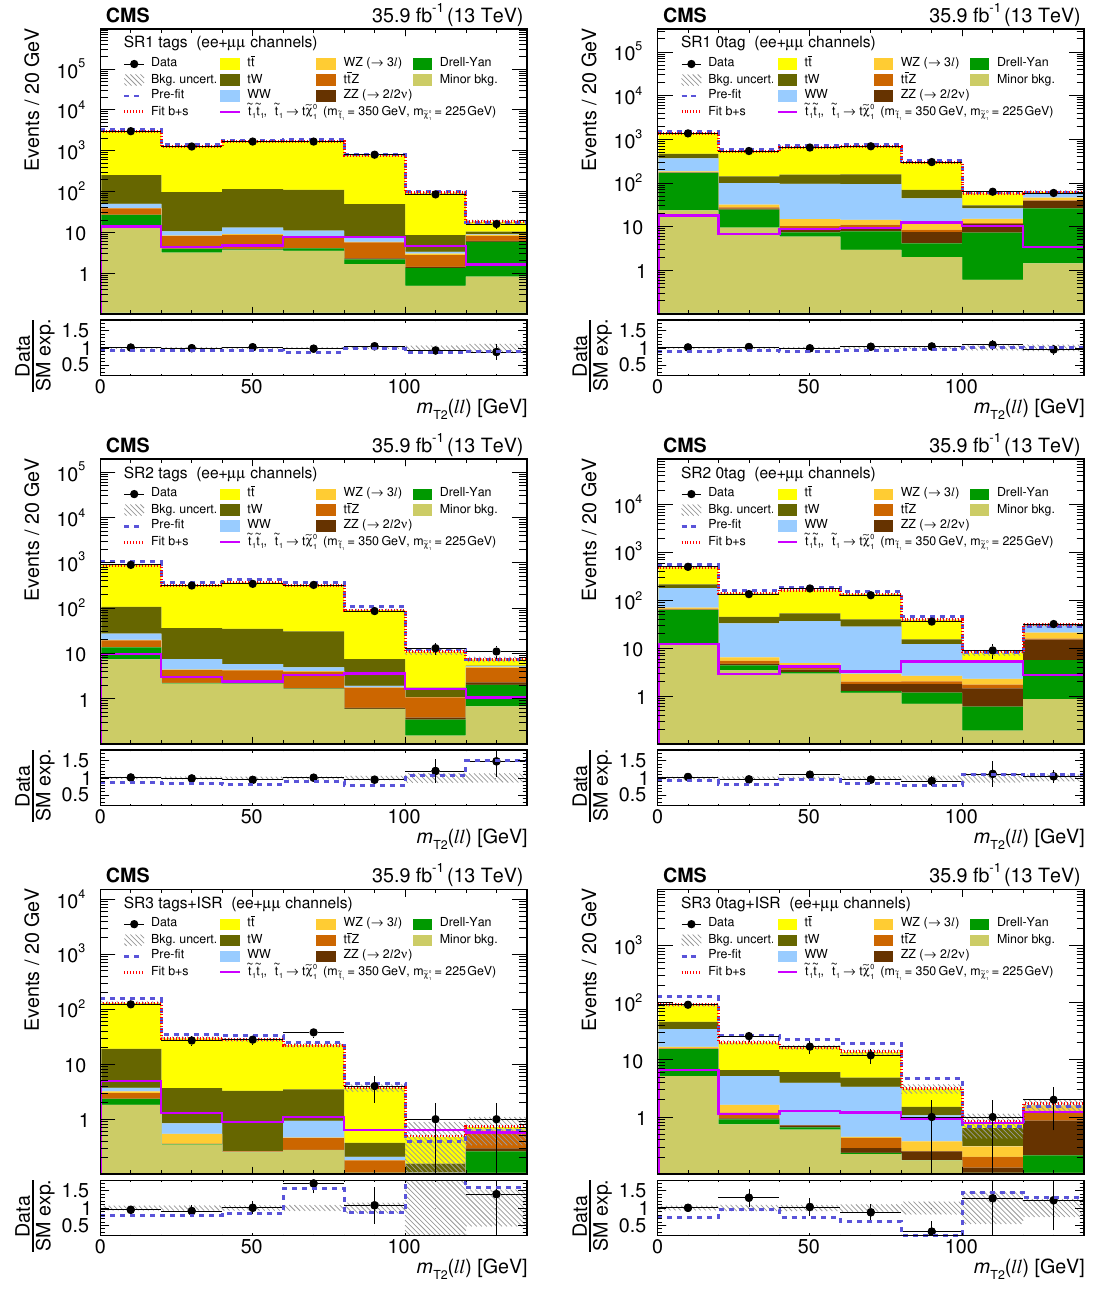
Figure 7 . The same distributions of m